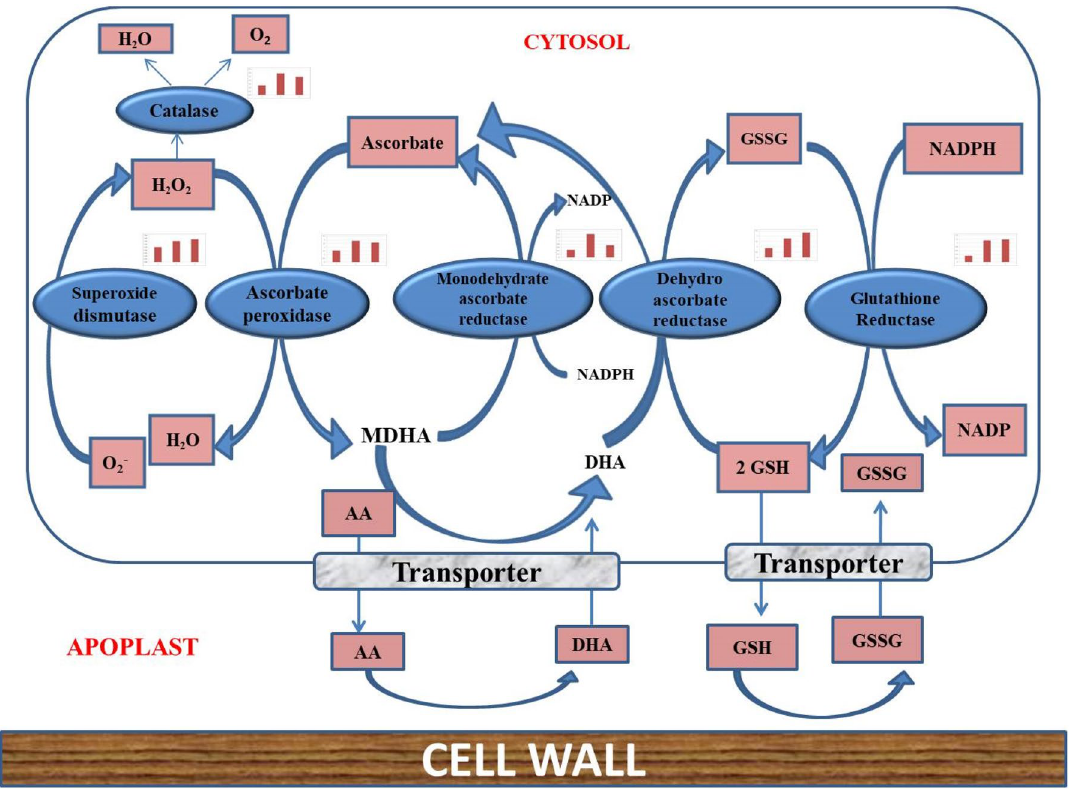
Figure 9. Differentially expressed genes of ROS pathway in response to saline